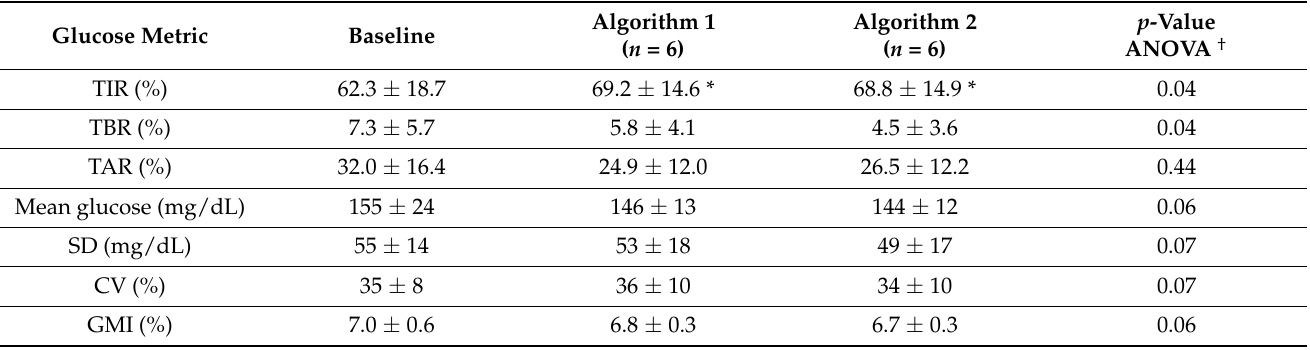
Table 4. Comparison of glucose metrics collected at baseline and after Algorithm 1 (DirectNet/JDRF) and Algorithm 2 (Ziegler) in patients treated with MDI therapy.